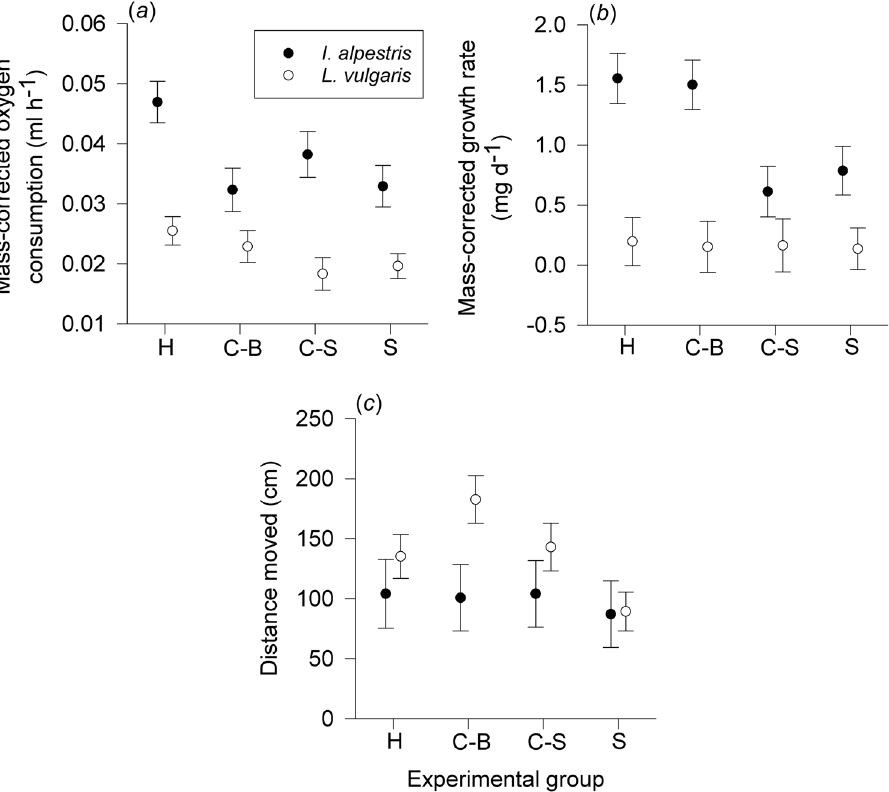
Figure 2. Influence of con- and heterospecific competitive interactions on newt traits. ( a ) Standard metabolic rates (minimum oxygen consumption), ( b ) somatic growth rates ([final body mass − initial body mass]/number of days of the experiment), and ( c ) spontaneous locomotor activity (distance moved during 30 min trial) in the juvenile newts Ichthyosaura alpestris and Lissotriton vulgaris . Metabolic and growth rates are body size- corrected means from a general linear model. Values are means ± s.e.m. C-B, bigger conspecifics; C-S, smaller conspecifics; H, individuals from heterospecific pairs; S,